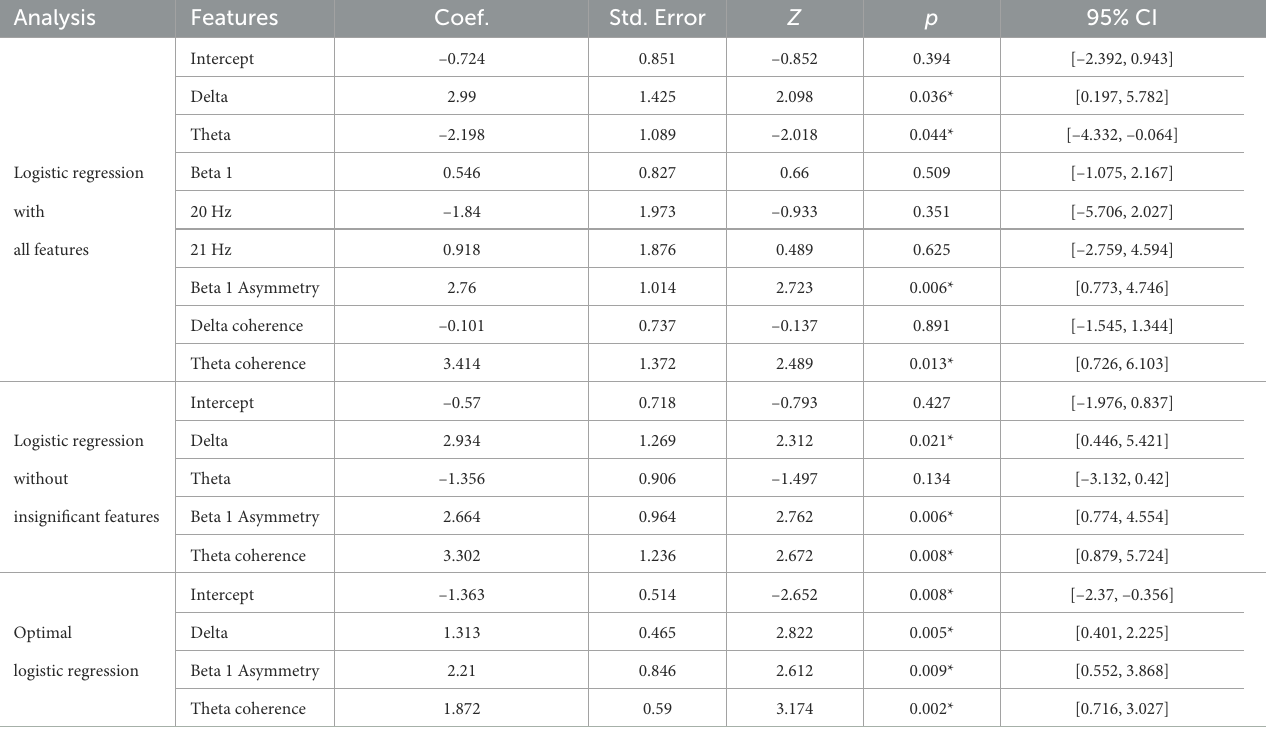
TABLE 6 Binary logistic regression and feature